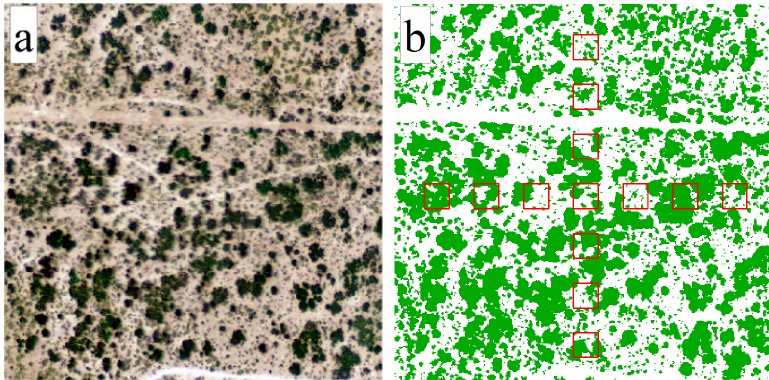
Figure 2. ( a ) 1 m resolution digital orthophoto of a 500 m plot, ( b ) classification result of woody plant (green) vs. the others and sampling of WELD pixels (red polygons).